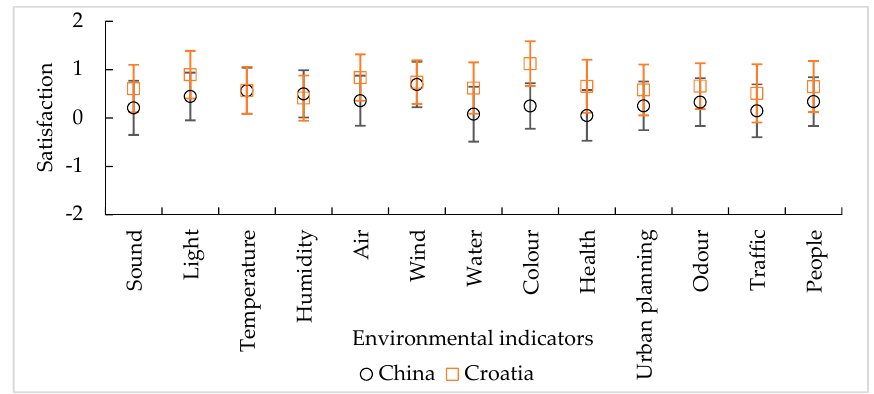
Figure 4. Average evaluation score of each environmental indicator in China and Croatia.